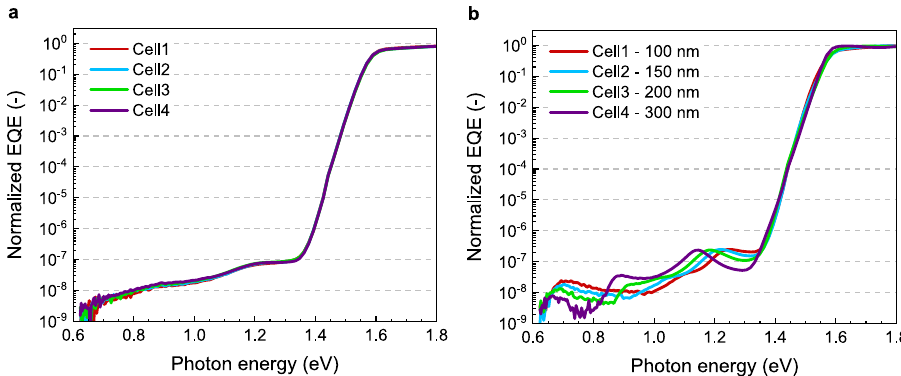
Fig. 2 Sub-bandgap EQE of four p – i – n perovskite solar cells using an ITO back electrode. a Without optical spacer or mirror. b With an MgF 2 optical spacer and a Ag mirror. The thickness of the MgF 2 layers was 100, 150, 200, and 300 nm as indicated in the